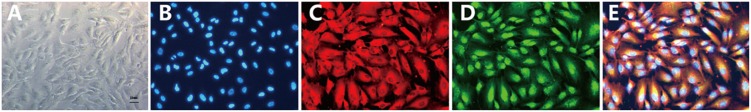
Culture and verification of HRMEC. (A) After 10-day culture, the cells showed an oval morphology and a contact-inhibited monolayer. (B) Cell nuclei were stained with DAPI (blue fluorescent). (C) CD31 was positive (red fluorescent). (D) vWF was positive (green fluorescent). (E) Merged picture revealed double staining positive for CD31/vWF. The cell morphology and immunofluorescent results verified the HRMEC cell type. HRMEC, human retinal microvascular endothelial cell; CD31, platelet endothelial cell adhesion molecule-1; vWF, von Willebrand factor.